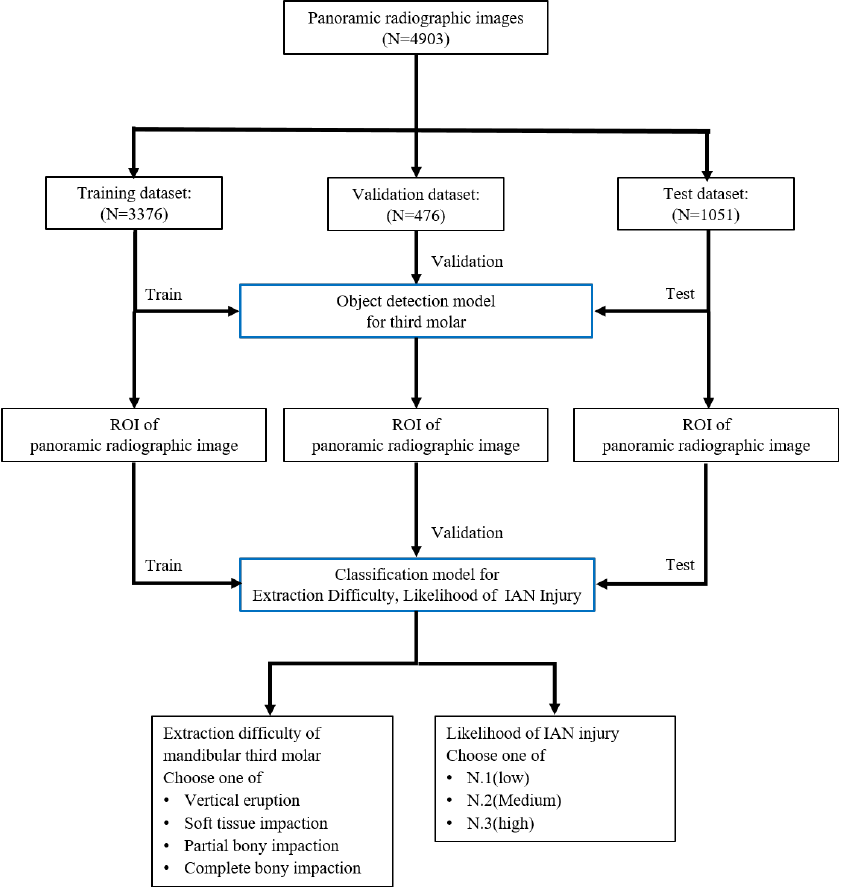
Figure 1. Overall